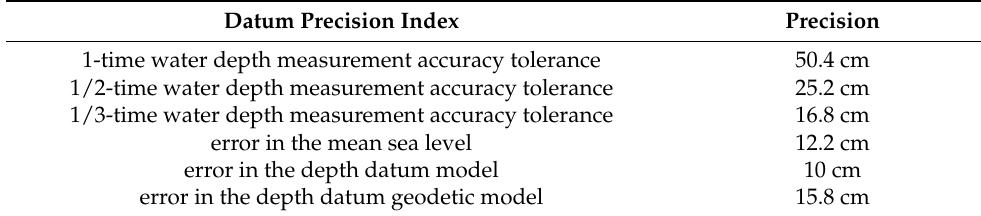
Table 4. Comparison of precision indexes of different